Question: In one sentence, what is this figure communicating?
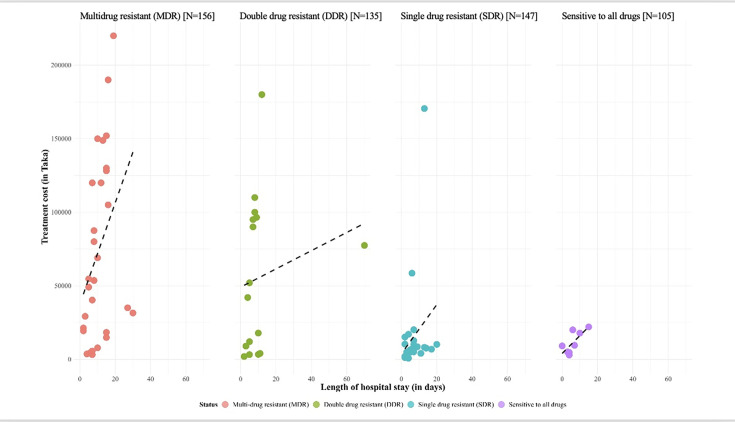
Answer: Correlation between treatment cost and length of hospital stay across different antibiotic resistance profiles.